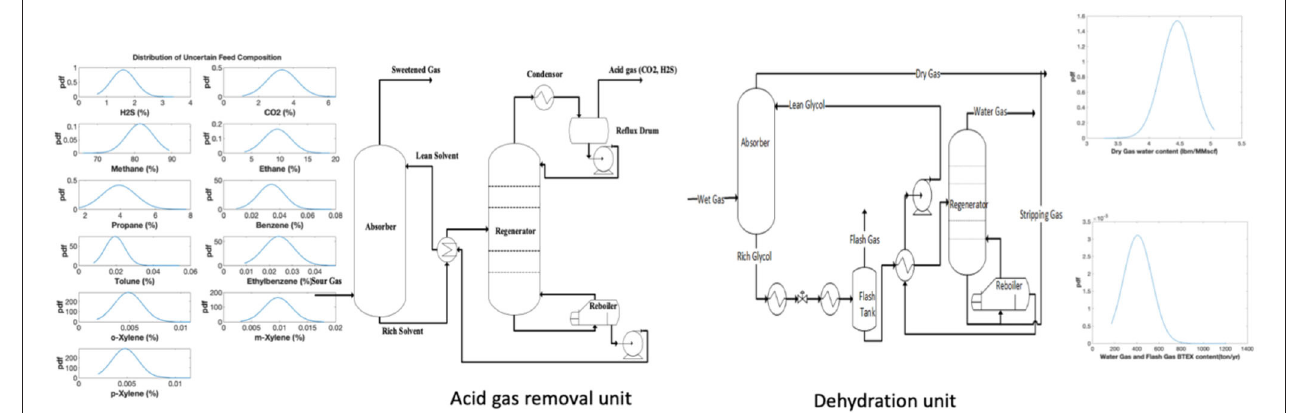
FIGURE 1 | Uncertainty propagation and quantification in NG processing.